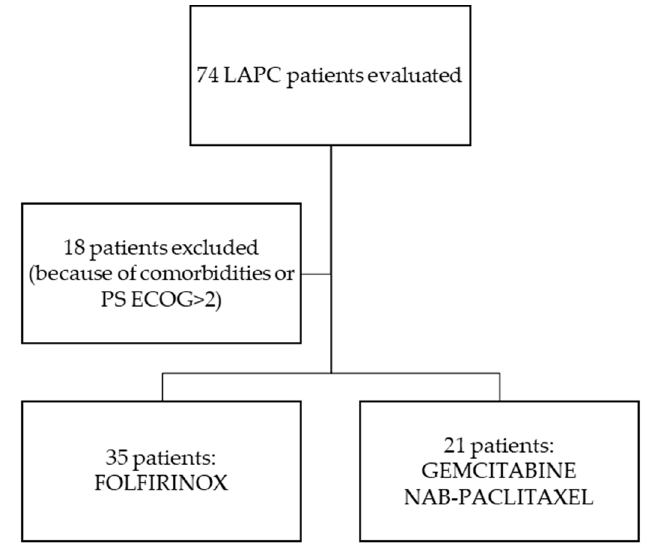
Figure 1. Flow chart in patients’ selection for analysis.